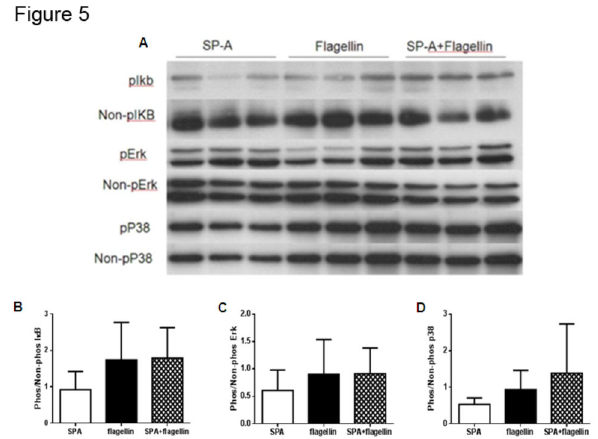
Figure 5. TLR5 Signaling is not Enhanced by SP-A Interactions with Flagellin. Immunoblot was used to compare the phosphorylated and non-phosphorylated TLR-5 signaling pathway including IκBα, ERK and p38 in cell lysates from MH-s cells following stimulation with SP-A, flagellin or flagellin with SP-A. Blot in panel A is a representative experiment. Densitometry was performed on three experiments with multiple replicates and expressed as the phosphorylated divided by the non-phosphorylated form (B, C, D). There were no significant differences between any of the stimulations. Data shown are from 20 minutes of stimulation, but there were also no differences between groups noted following 10, or 60 minutes of stimulation as well (data not shown).